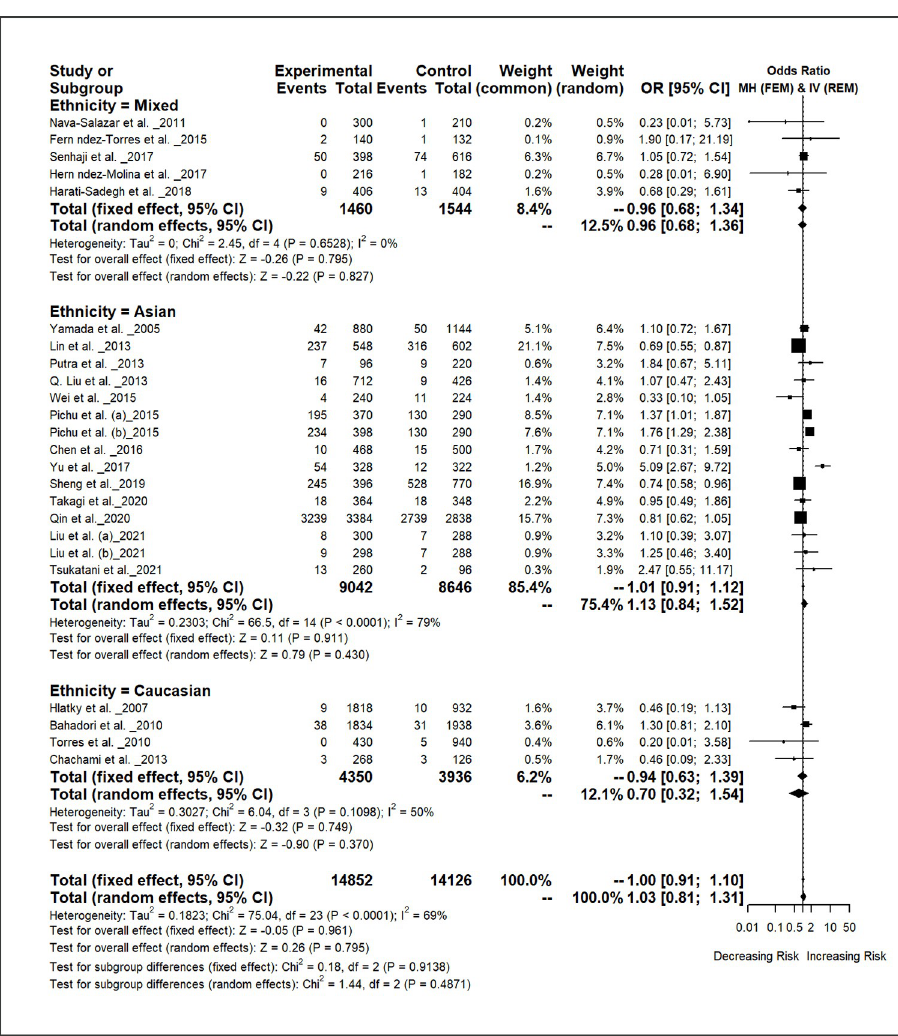
Fig 3. Forest plot of HIF1A 1790 G/A polymorphism and overall disease risk for the different ethnic populations under allelic model [ A vs. G